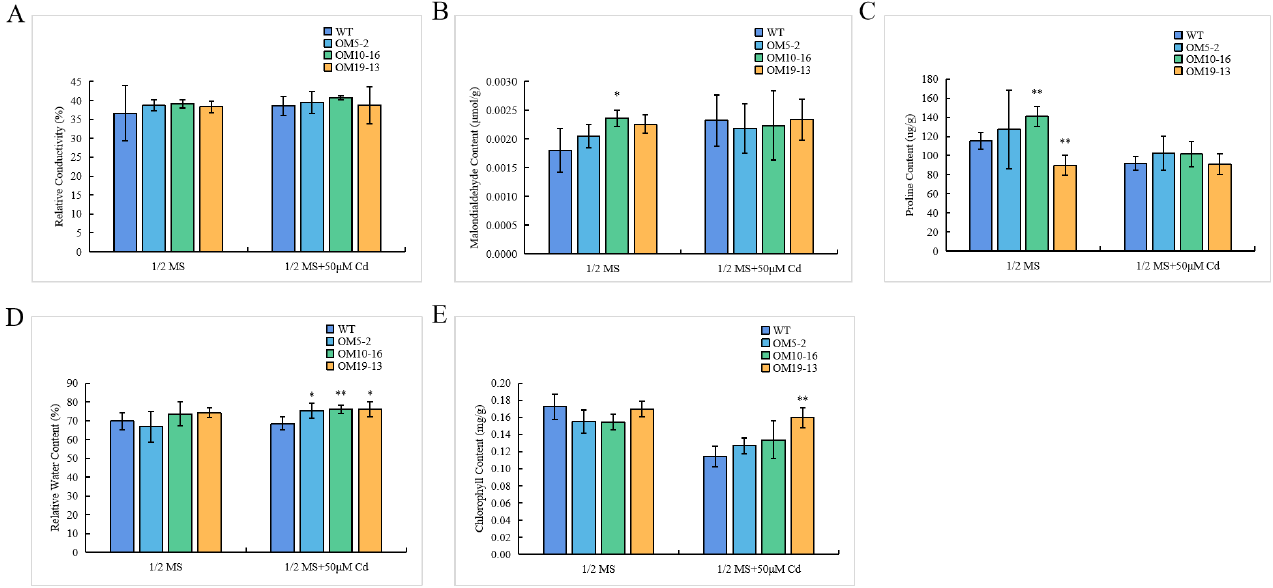
Figure 7. Physiological parameter analysis of Arabidopsis seedlings under Cd treatment. ( A – E ) Rel- ative conductivity ( A ), malondialdehyde content ( B ), proline content ( C ), relative water content ( D ), and chlorophyll content ( E ) of Arabidopsis seedlings grown on a 1/2 MS medium without Cd (as the control) or with 50 µM of Cd for 8 days. WT, wild-type Arabidopsis ; OM5-2, OM10-16, and OM19- 13, T 4 PvHMA2.1 ectopically expressed Arabidopsis lines. The data represent the mean ± SD, n = 4. Asterisks indicate significant differences from the WT: one asterisk indicates p < 0.05, and two aster- isks indicate p < 0.01.